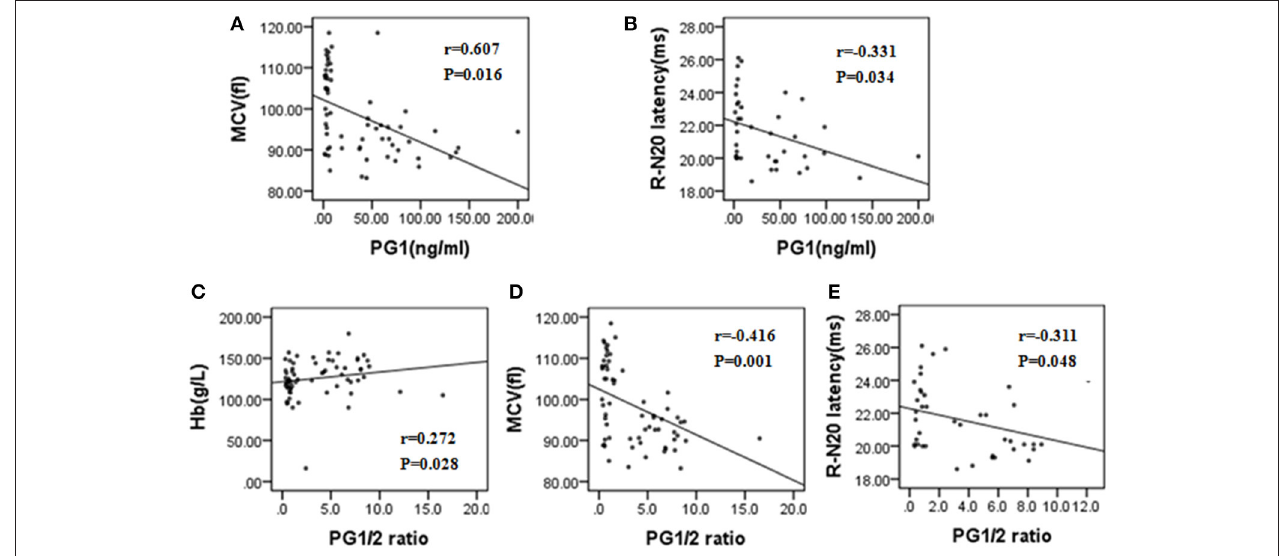
FIGURE 2 | (A–E) Correlation analysis of PG1, PG1/2 ratio with other laboratory tests and electrophysiological parameters in patients with subacute combined degeneration. MCV, mean corpuscular volume; Hb, hemoglobin; R-N20, right N20 in somatosensory evoked potential test; PG1, pepsinogen 1; PG1/2, pepsinogen 1/pepsinogen.